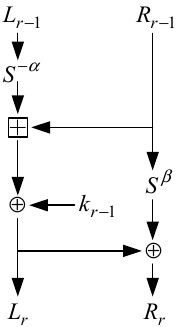
Figure 1. Round function of SPECK.